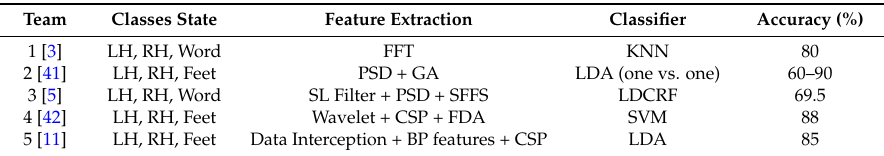
Table 12. Classification accuracy of three-class based motor imagery.